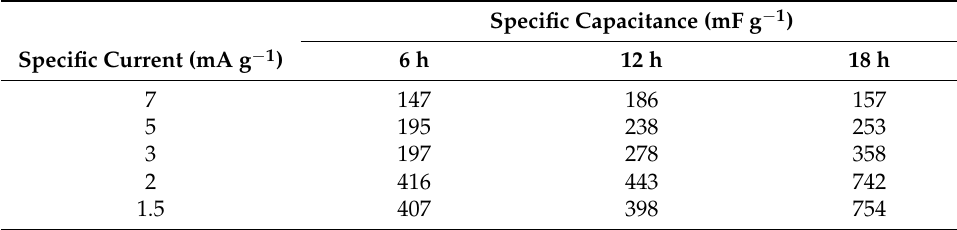
Table 6. Specific capacitance of ZnMn 2 O 4 measured at different specific currents.